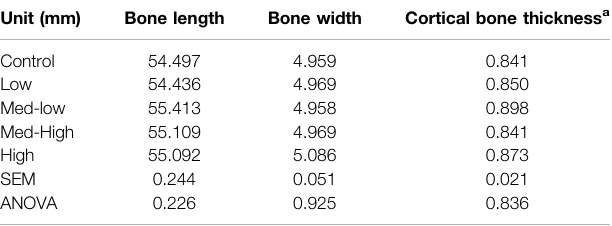
TABLE 4 | Tibia length, width, and cortical bone